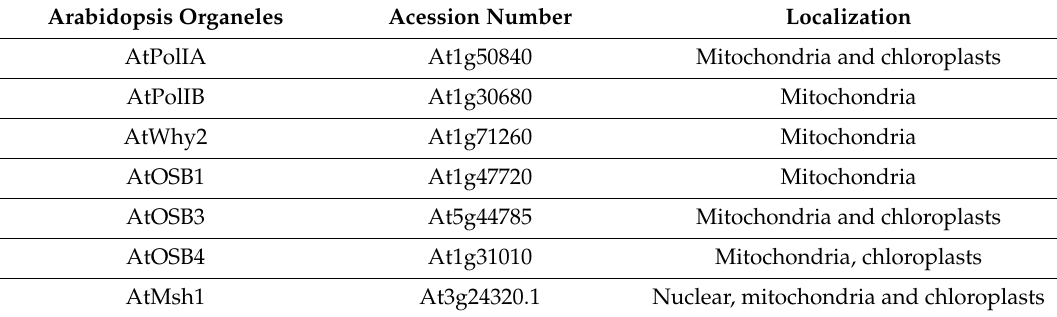
Table 3. Unique proteins involved in DNA metabolism in flowering plant mitochondria. Arabidopsis